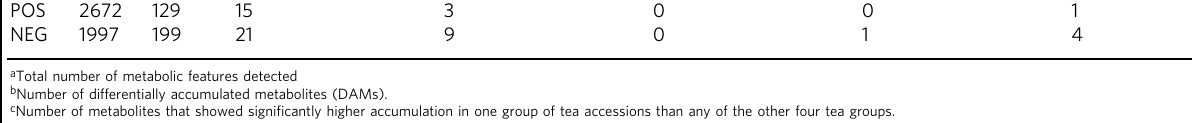
Table 2 Total number of detected, differentially accumulated, and signature metabolites identi fi ed in this study. Mode Total a DAMs b Signature metabolites in group 1